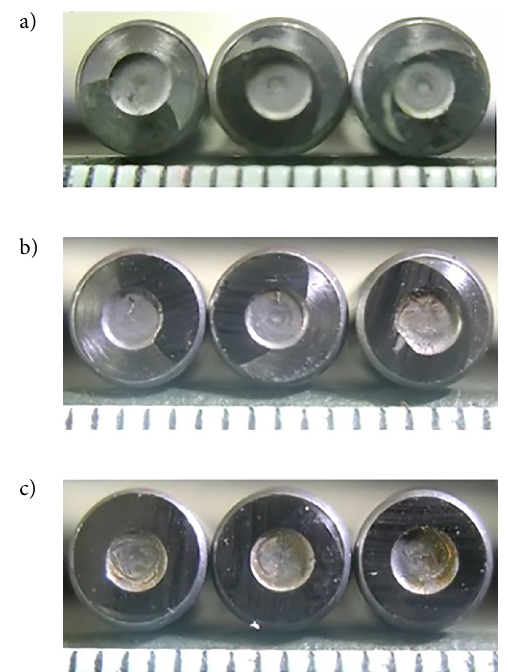
Figure 2. The image of friction samples in lubrication conditions: a – using rapeseed oil; b – RME; c – RME with goose fat (dark area represents a track of cooperation)